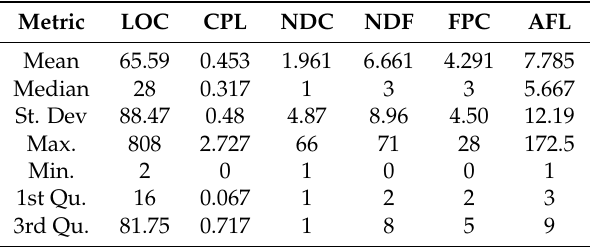
Table 4. Volume metrics of smart contracts belonging to Agile ICO